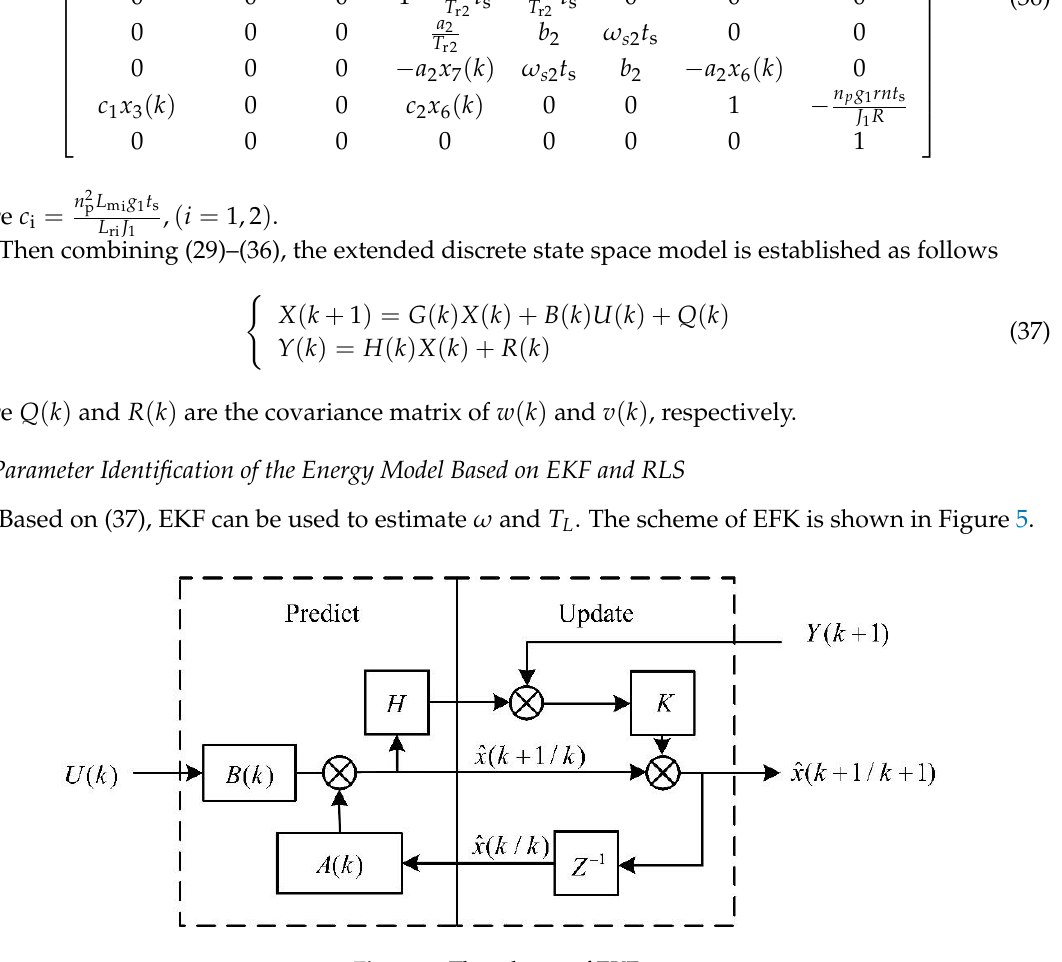
Figure 5. The scheme of EKF.